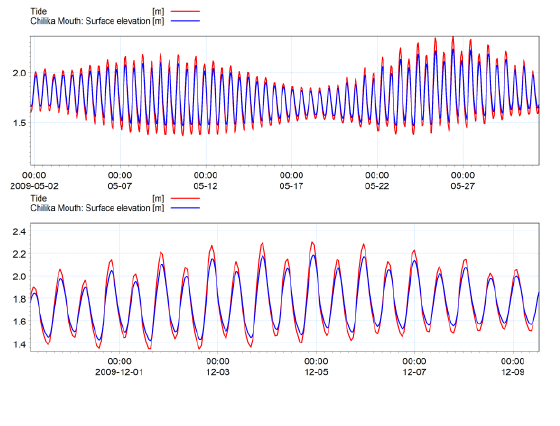
Figure 5. Validation of simulated surface water levels